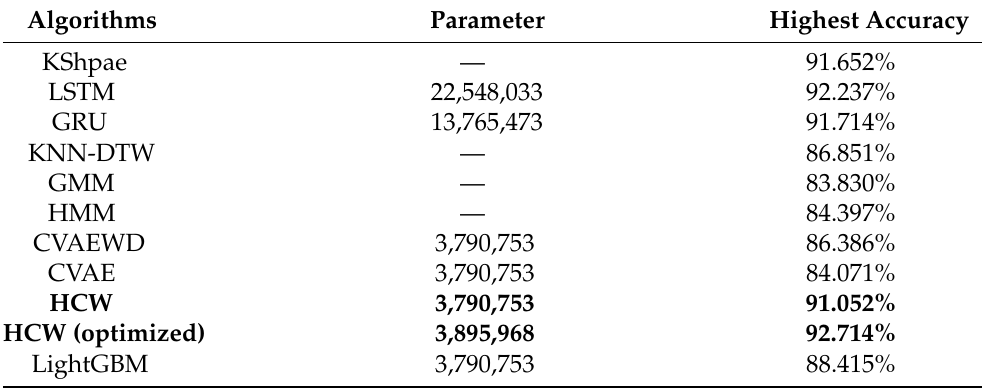
Table 4. Comparison of the results of different